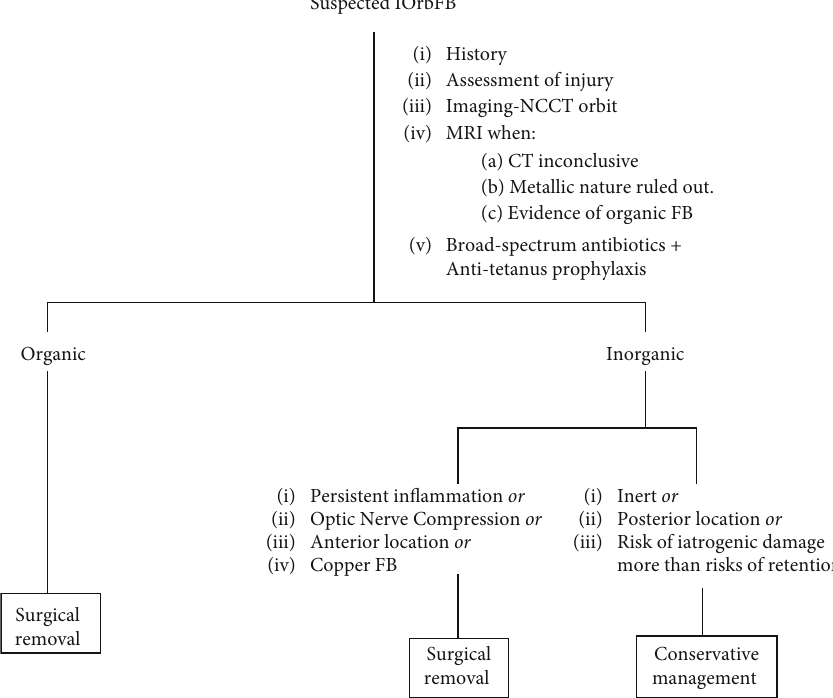
Figure 5: Approach to an intraorbital foreign body